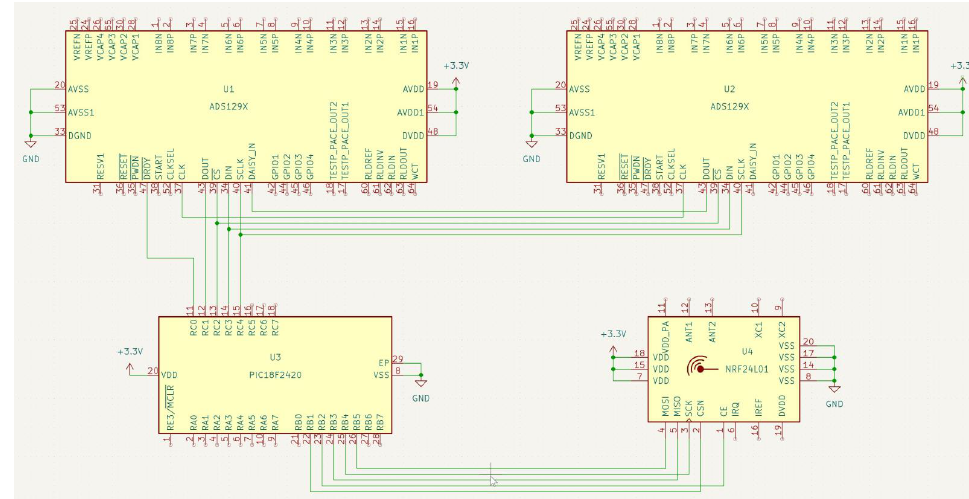
Figure A1. A scheme of one module of the EEG platform, included: (U1, U2) ADS129x AFEs; (U3) Microcontroller PIC18F2420; (U4) Transmitter-receiver part NRF24L01.